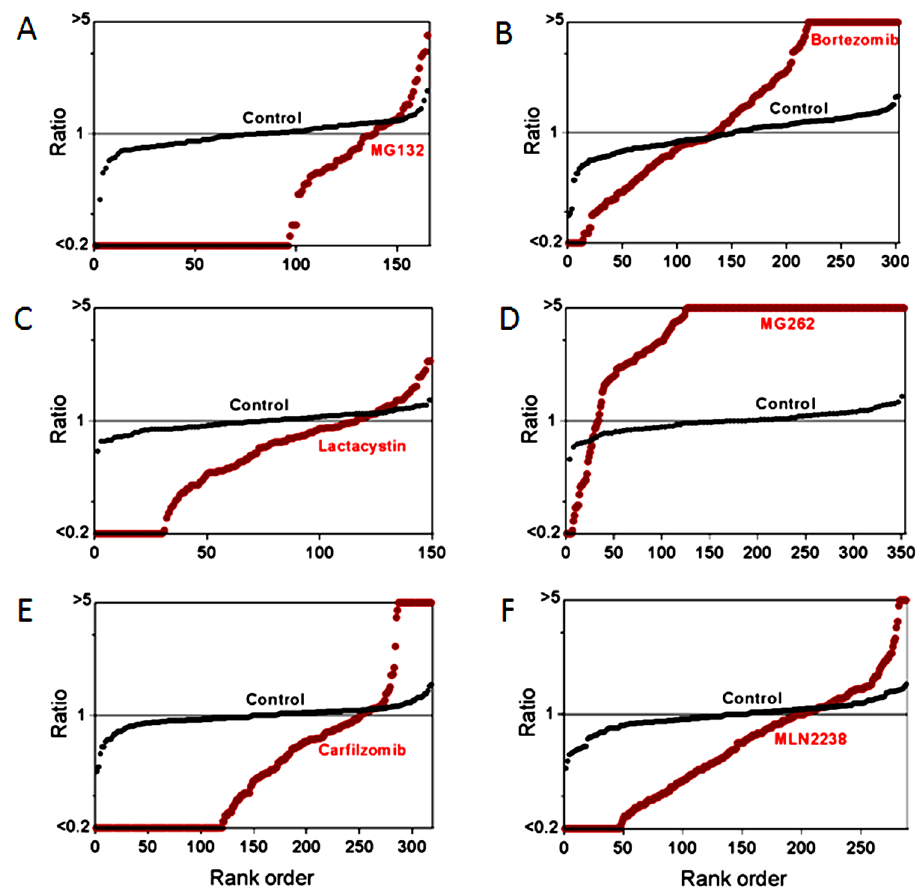
Figure 4. Summary plots of the peptidome of SH-SY5Y cells in response to proteasome inhibitors. Panels A–F represent data from experiments on SH-SY5Y cells treated with (A) 2.5 m M MG132 for 35 min, (B) 0.5 m M bortezomib for 1 hour, (C) 1 m M clasto-Lactacystin b -lactone for 35 min, (D) 1 m M MG262 for 35 min, (E) 1 m M carfilzomib for 35 min, (F) 1 m M MLN2238 for 35 min. Specifications and criteria for making the summary plots are described in Figure 3. The data used to generate the plot shown in panel B was previously published